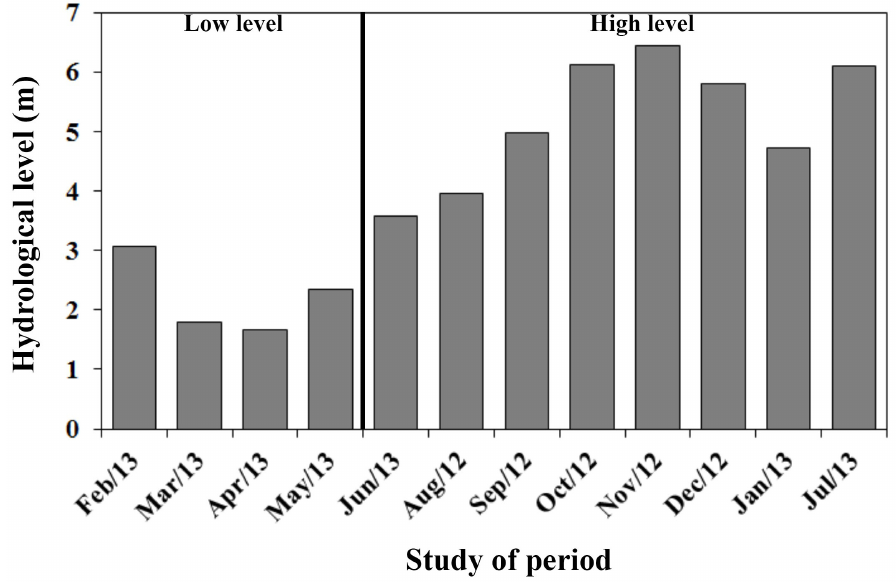
Figure 2. Hydrological level among the studied period, the left the low level and the right the high level, in the Chasqueiro reservoir, southern